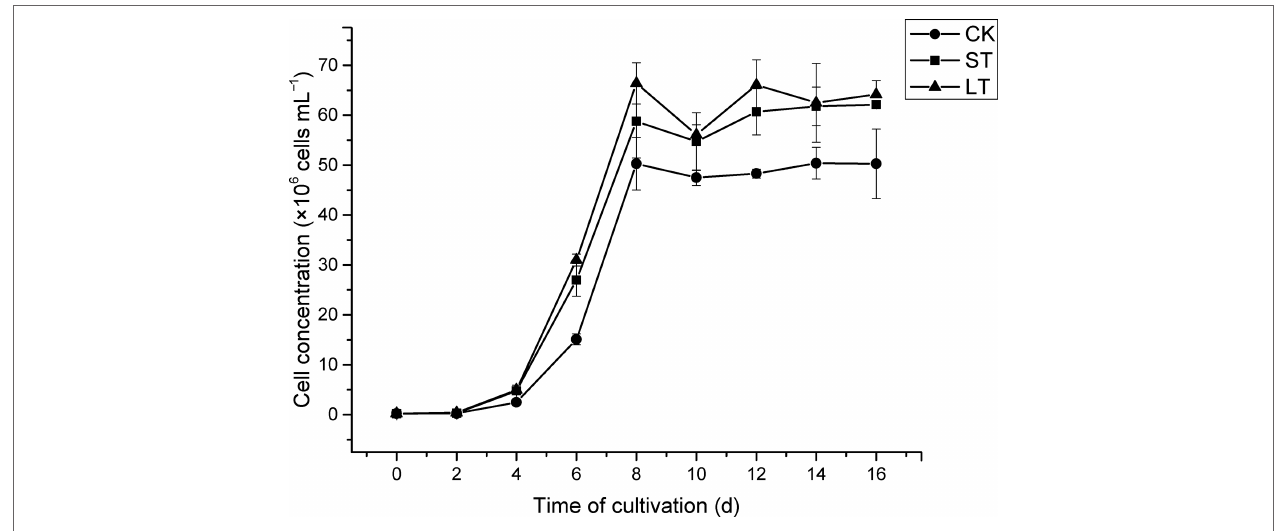
FIGURE 1 | The growth curve of N. oceanica cultivated at different cultivated conditions. The error bars represent the standard deviation (SD), n = 3.